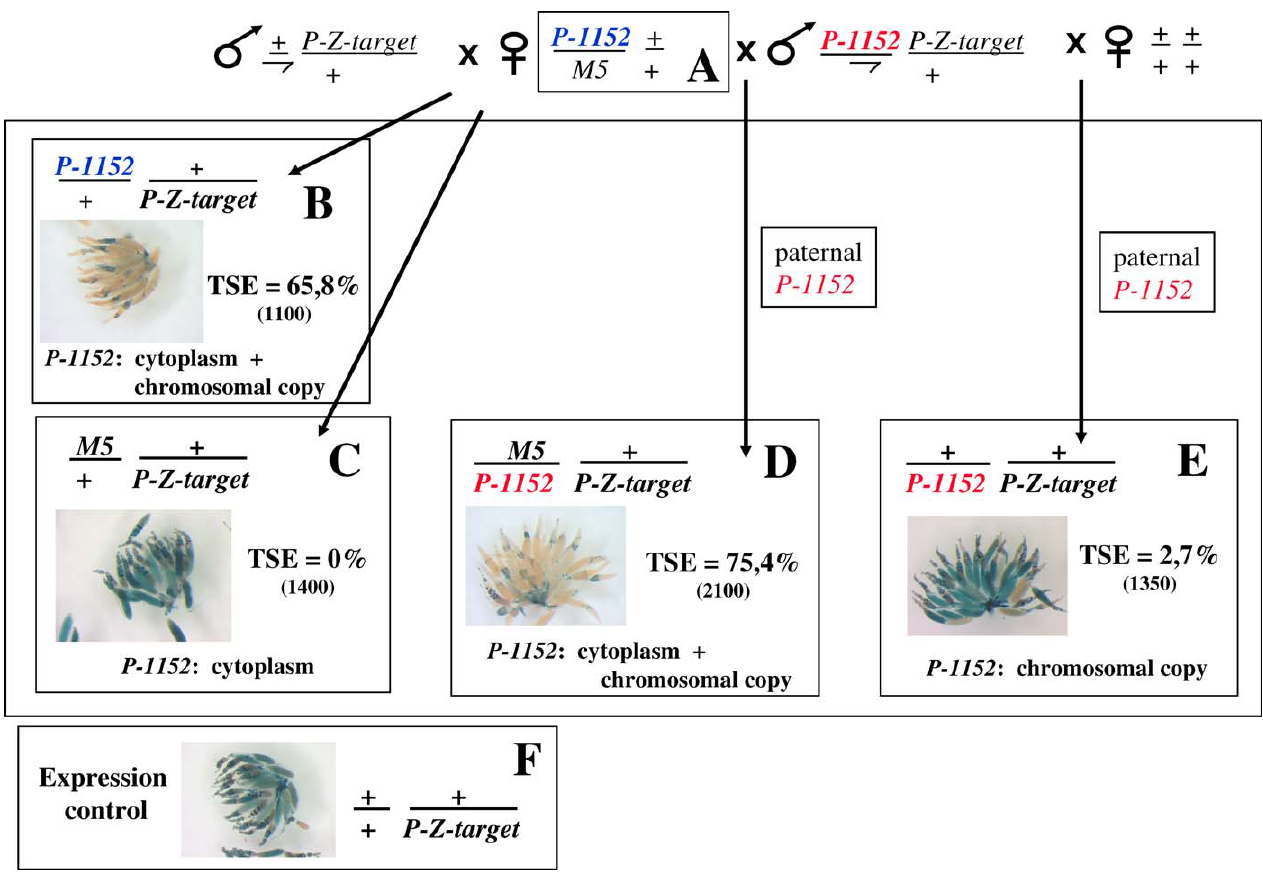
Figure 3. TSE Involves a Strictly Maternally Transmitted Component ‘‘ A ’’ females, hemizygous for the P-1152 telomeric silencer locus, were established by crossing homozygous P-1152 females and males carrying the Muller-5 chromosome (M5) devoid of P sequence and marked by the semidominant Bar marker. These ‘‘ A ’’ females were crossed with males carrying the BQ16 euchromatic P-lacZ as target in order to recover the ‘‘ B ’’ and ‘‘ C ’’ females having inherited or not P-1152 . ‘‘ A ’’ females were also crossed with P-1152; BQ16 males in order to recover the ‘‘ D ’’ females having inherited P-1152 from the father. P-1152; BQ16 males were also crossed with females devoid of P transgenes producing ‘‘ E ’’ females genotypically similar to ‘‘ D ’’ females, with the exception that they have inherited a naive cytoplasm, whereas, ‘‘ D ’’ females have inherited a P-1152 cytoplasm. ‘‘ B–E ’’ females were scored for TSE. ‘‘ F ’’ females show an expression control of the